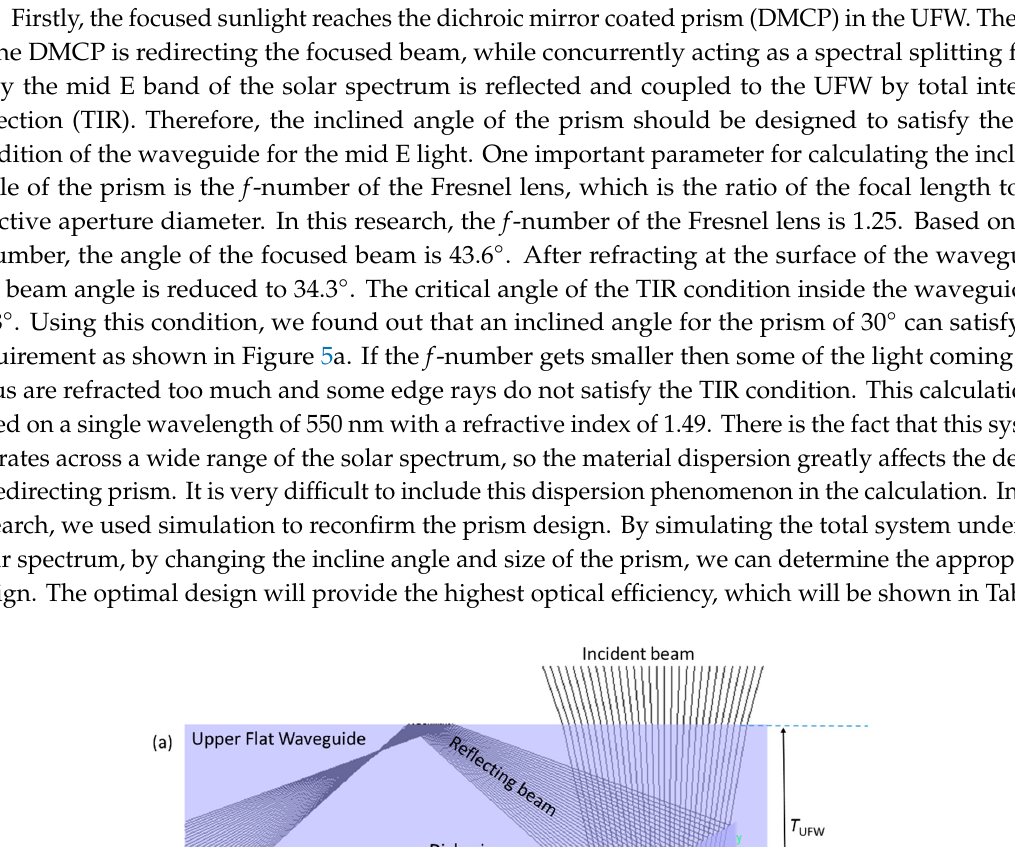
Figure 4. Details of double flat waveguides with an exaggeration at the position of redirecting prisms.